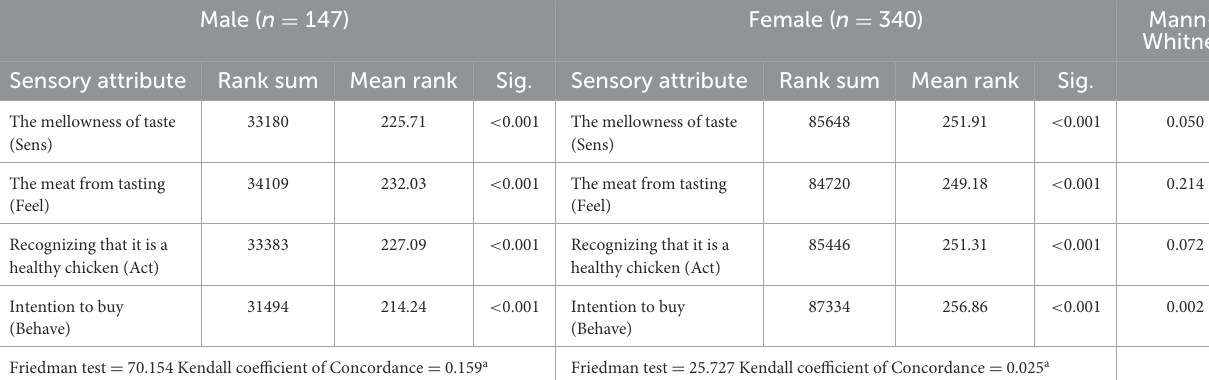
TABLE 6 Friedman test of sensory attributes difference between males and